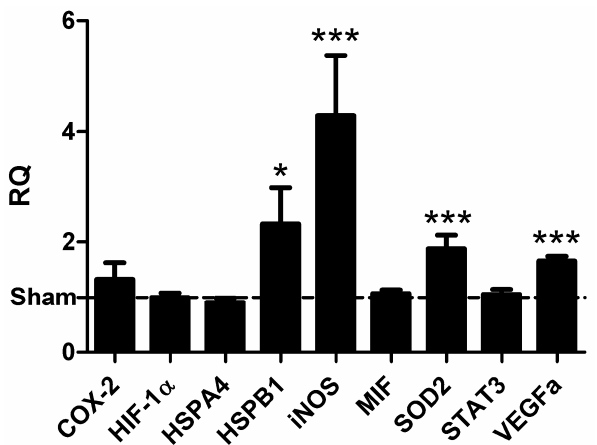
Figure 3. Argon preconditioning induces the transcription of heat shock protein (HSP) B1 (HSP27), superoxide dismutase 2 (SOD2), vascular endothelial growth factor (VEGF), and inducible nitric oxide synthase (iNOS). Eight hours after argon preconditioning, mRNA was isolated, and RT-PCR was performed. mRNA levels were normalized to glyceraldehyde-3-phosphate dehydrogenase (GAPDH) and the relative quantity (RQ) values were calculated according to the ΔΔ Ct method. Data represented means ± SEM of at least 13 independent experiments. *, p < 0.05 and ***, p < 0.001.